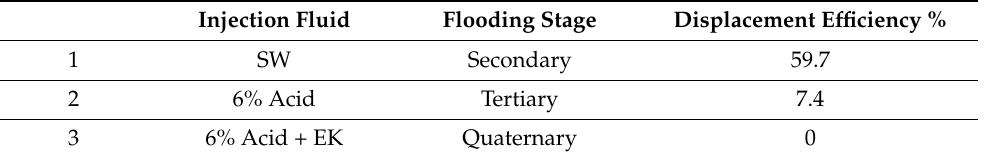
Table 8. Summary of